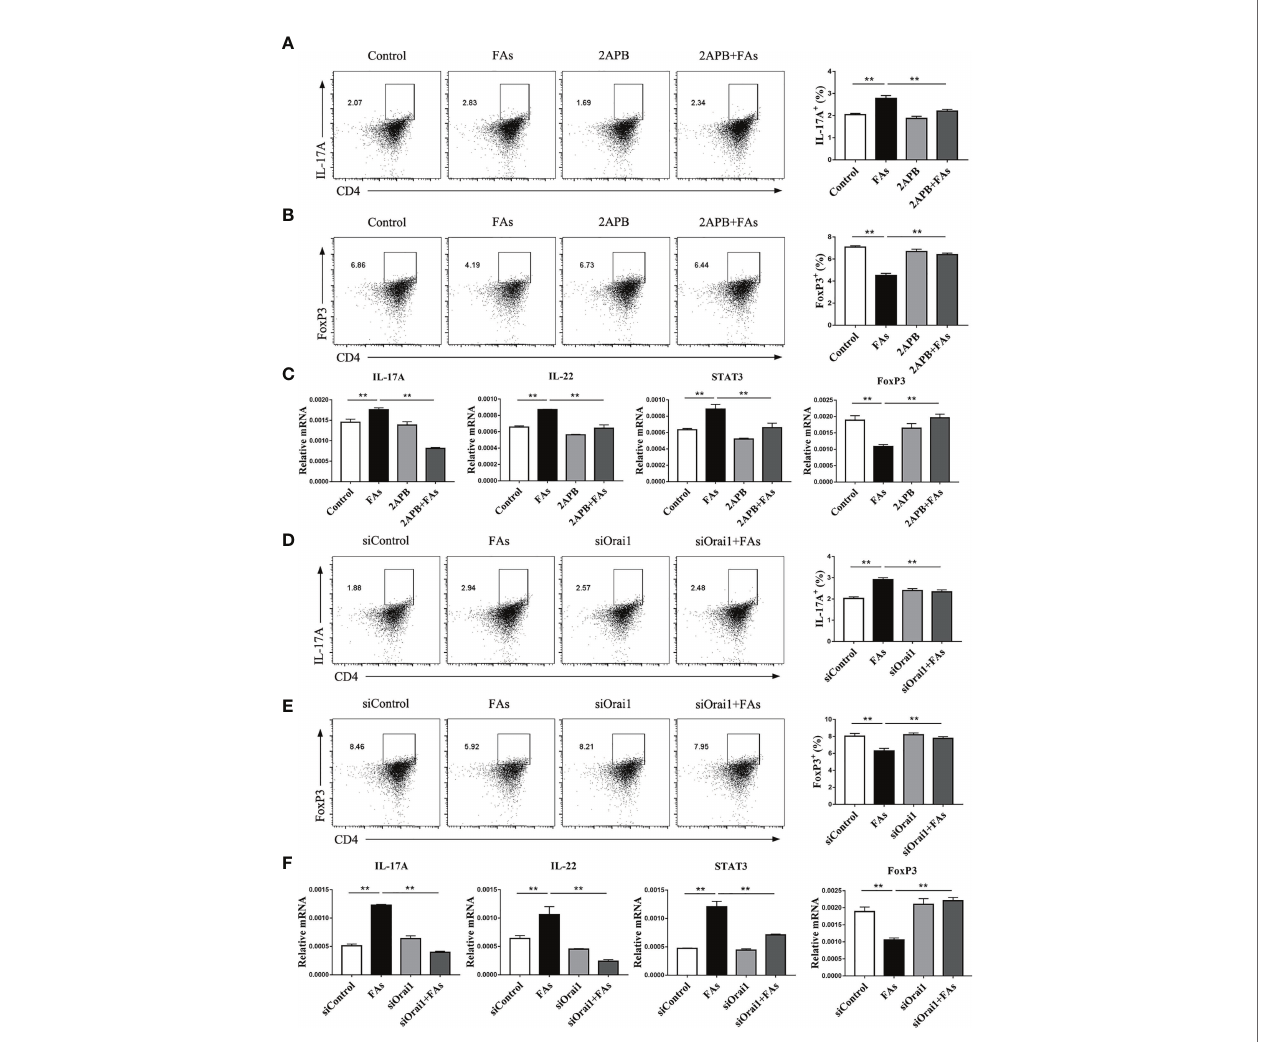
FIGURE 10 | Inhibiting or silencing ORAI1 affects FAs-induced expression of IL-17 and Foxp3 during differentiation of Th17 and Treg cells. CD4 + T cells were sorted from spleens from 1-d old calves and stimulated with 2APB or siORAI1 before FAs treatment with 12 h (A) Populations of IL-17 cytokine-expressing CD4 T cells in treatment with 2APB (n = 3 per group). (B) Populations of FoxP3 expressing CD4 T cells in treatment with 2APB (n = 3 per group). (C) Relative mRNA expression of IL-17, STAT3, IL-22 and FoxP3 in treatment with 2APB (n = 4 per group). (D) Populations of IL-17 cytokine-expressing CD4 T cells in treatment with siORAI1 (n = 3 per group). (E) Populations of FoxP3 expressing CD4 T cells in treatment with siORAI1 (n = 3 per group). (F) Relative mRNA expression of IL-17, STAT3, IL-22 and FoxP3 in treatment with siORAI1 (n = 4 per group). The data of the control were used to normalize other treatments. Comparisons among groups were calculated using a one-way ANOVA with a Duncan correction. The data presented are the mean ± SEM, **P ≤ 0.01 indicate differences from control or FAs